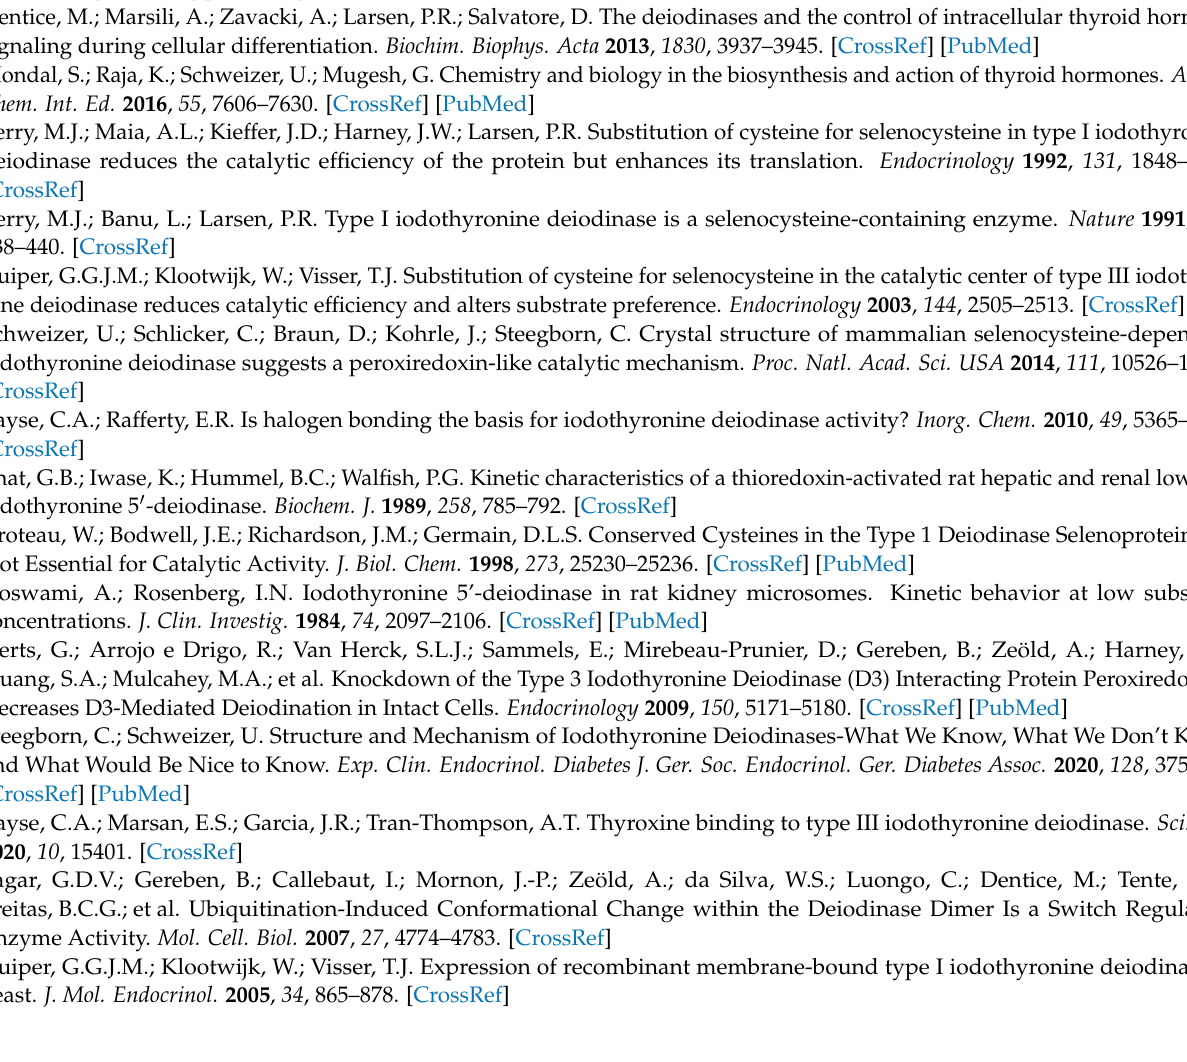
Figure A5. Expression of DIO1 mutants in COS7 cells. Western blot directed against the Flag-tag shows that clones transfected with the E156T and Y153F mutations showed weak expression of full-length DIO1. Deiodinase activities of the E156T and Y153F clones were not significantly higher than non-transfected controls.